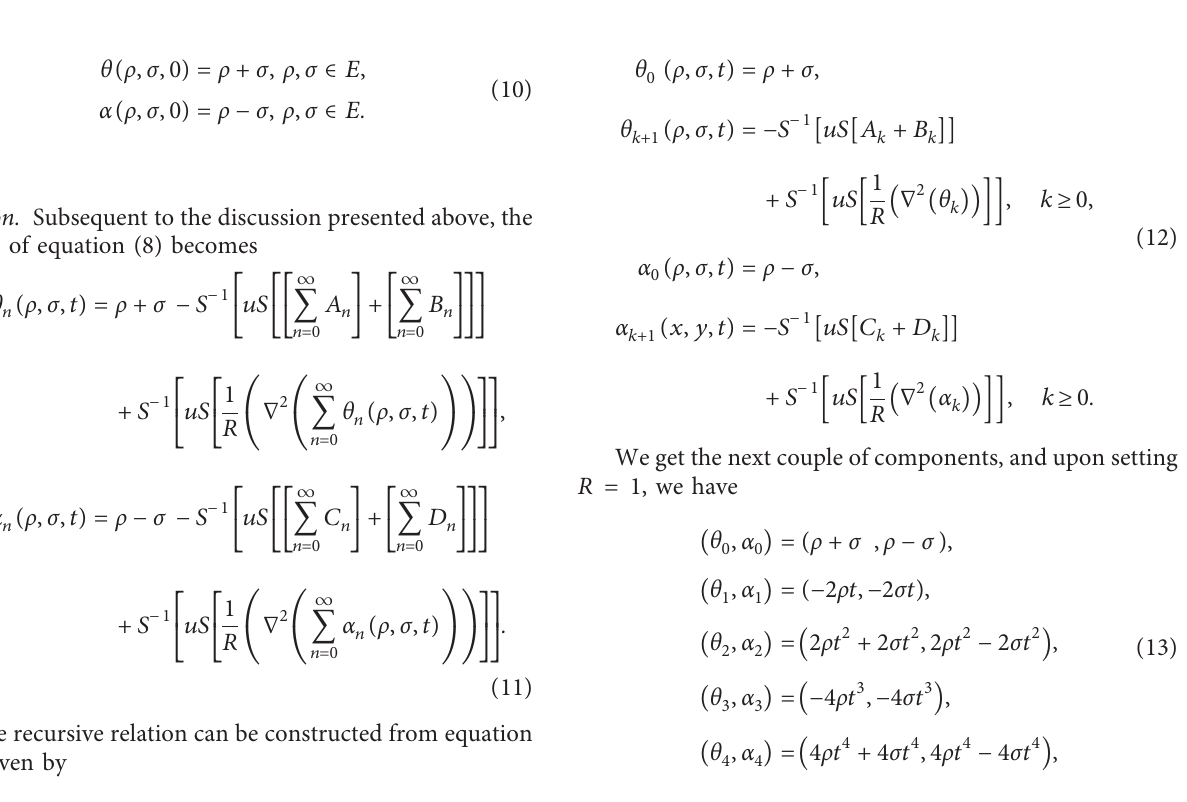
Figure 2: Distributions of approximation solutions for α ( ρ , σ , t ) at (a) t � 0 . 01 and (b) t � 0 . 5 with R � 100, for Example